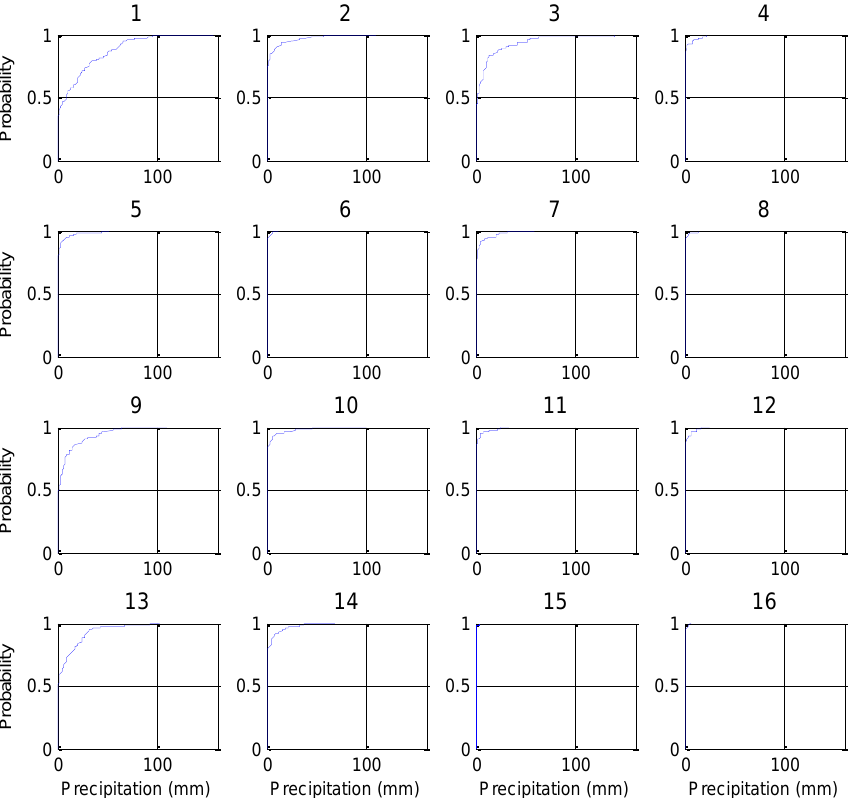
Figure 6. Cumulative probability distribution function (CDF) of precipitation for the 16 SOM nodes corresponding to the training results.